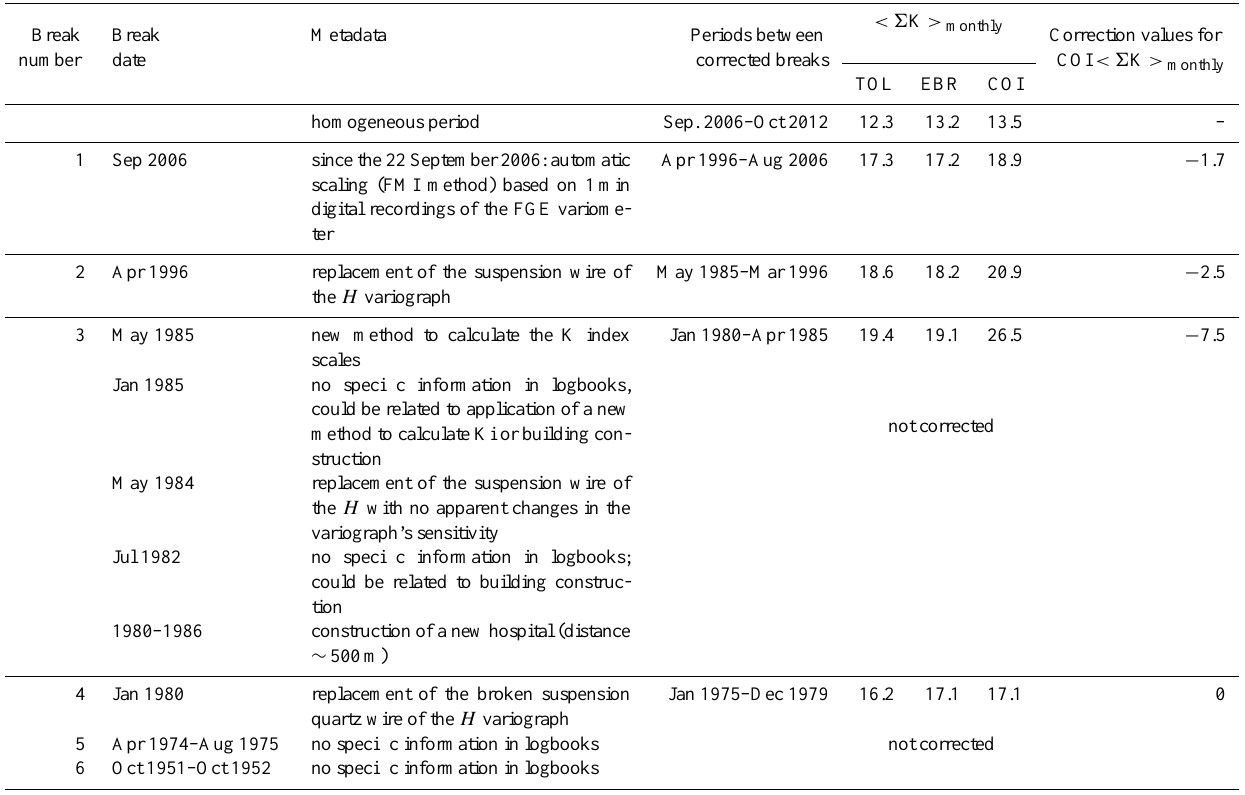
Table 1. A list of possible homogeneity breaks in COI Ki series for the period 1951 to 2012 found using metadata, visual analysis and statistical homogeneity tests. The last column shows values of <6 K > monthly used to correct detected breaks in COI Ki series, computed from comparison of TOL, EBR and COI values for periods between corrected breaks. Since the EBR series starts in January 1975, the correction value for the earlier period is estimated both using two reference series for the period 01/1975–12/1979 and using one reference series for the period 09/1951–12/1979. In both cases this correction is